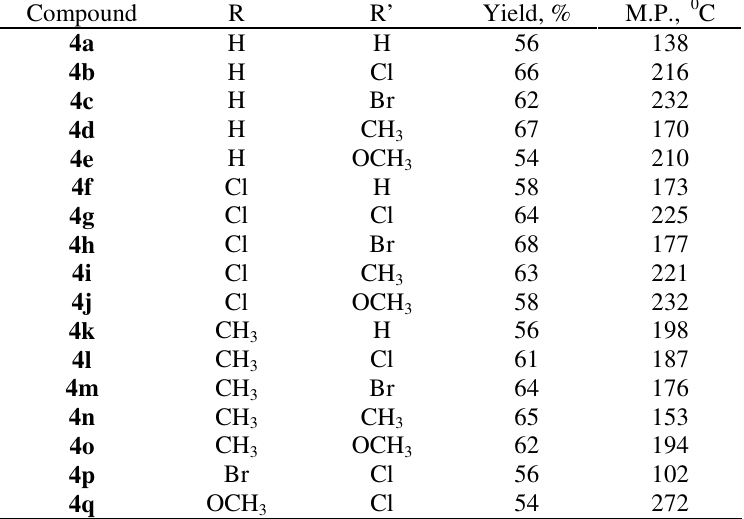
Table 2. Characterization data for the synthesized compounds ( 4a-q )